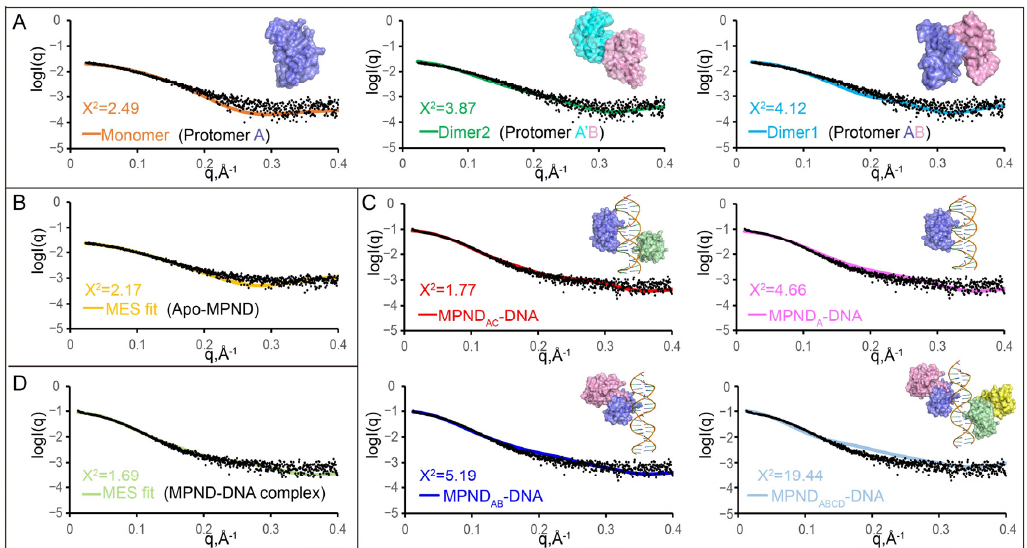
Figure 5. Analysis of the apo–MPND and MPND–DNA in solution via the SAXS (small-angle X-ray scattering) experiment. ( A ) Comparison of the SAXS experimental data (black dots) and the calculated scattering profiles for apo–MPND at 1.25 mg/mL. ( B ) Comparison of the SAXS experimental data (black dots) and the theoretical scattering curves of apo–MPND from the MES fit. ( C ) Comparison of the SAXS experimental data (black dots) and the calculated scattering profiles for the MPND–DNA complex at 1.25 mg/mL. ( D ) Comparison of the SAXS experimental data (black dots) and the theoretical scattering curves of the MPND–DNA complex from the MES fit.